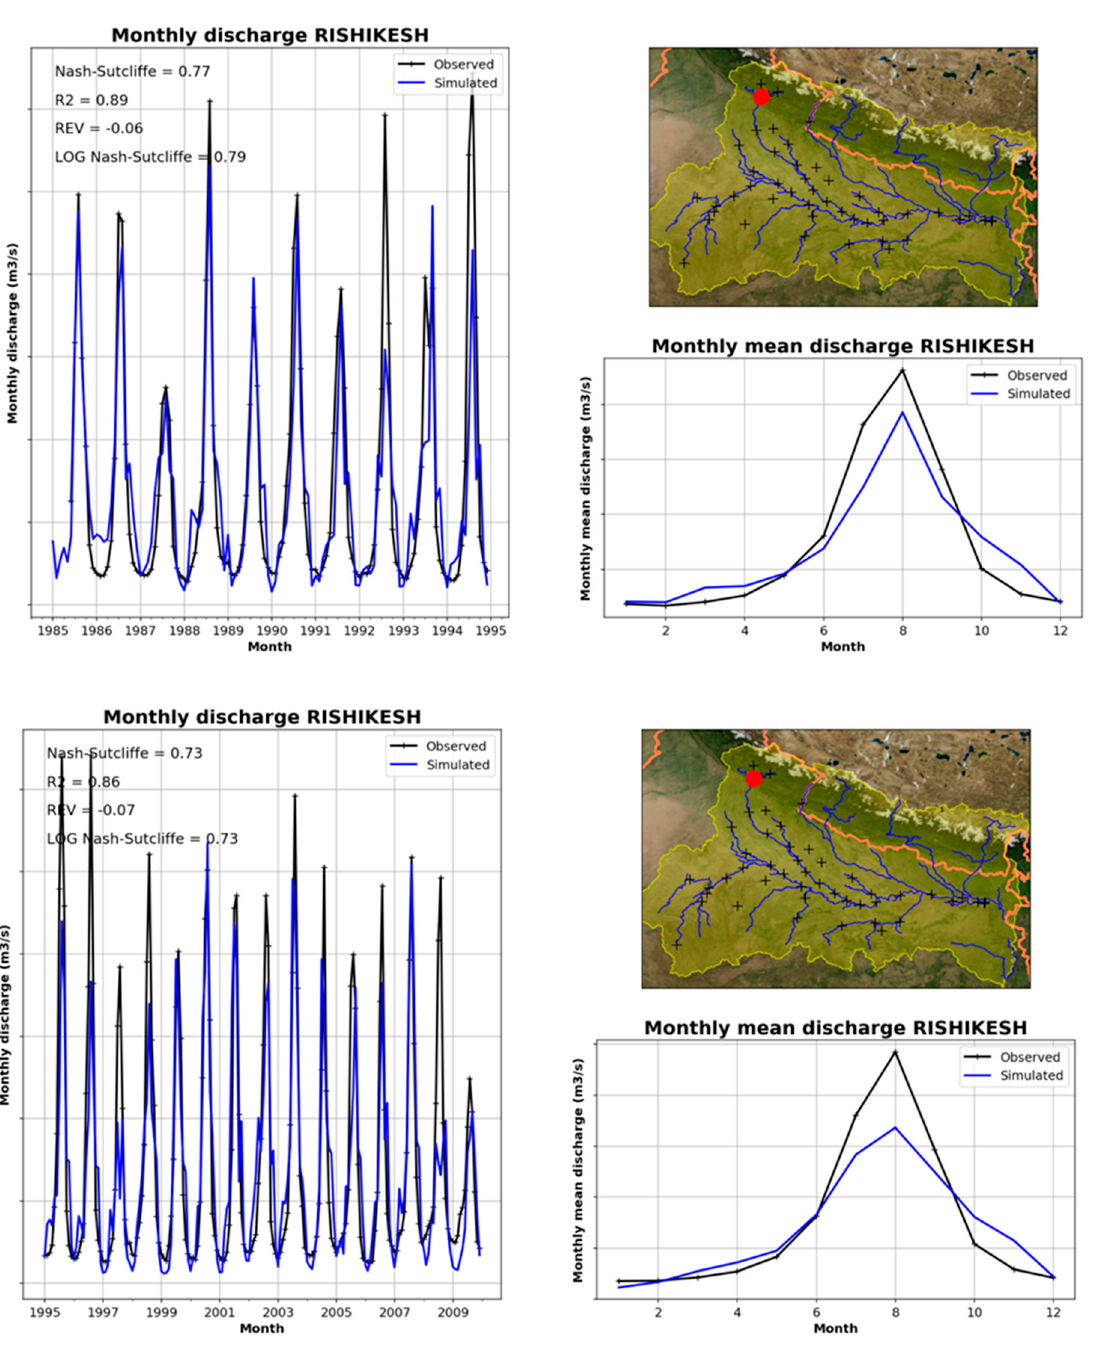
Figure 7. Validation (1985–1994, top) and calibration (1995–2009, bottom) results for the Ganga River at Rishikesh; monthly discharges (left), mean monthly discharges (right bottom) and location of the station (red dot on map right top).